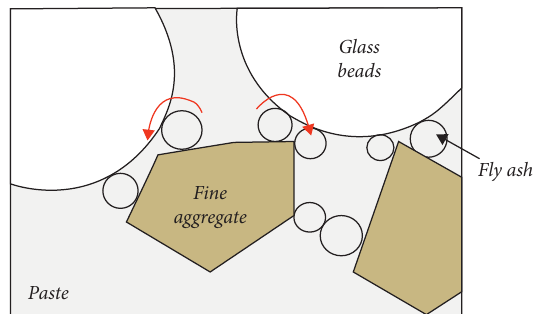
Figure 1: Ball-bearing effect of fly ash on the interaction between fine aggregates, reproduced from [17], with permission from Elsevier, 2021.